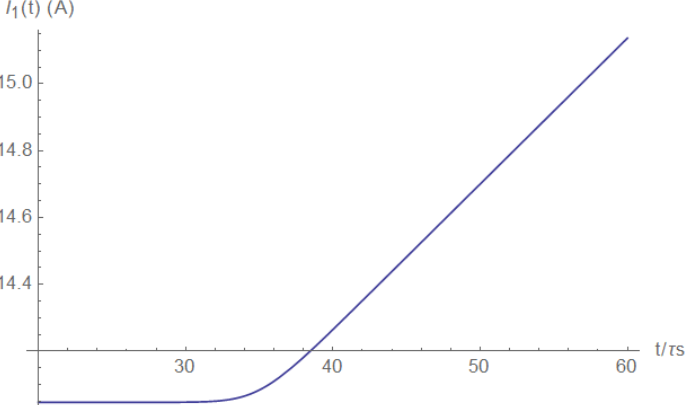
Figure A17. Source current right after the